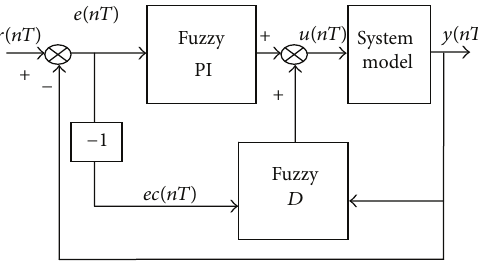
Figure 4: Discrete-time Fuzzy PID